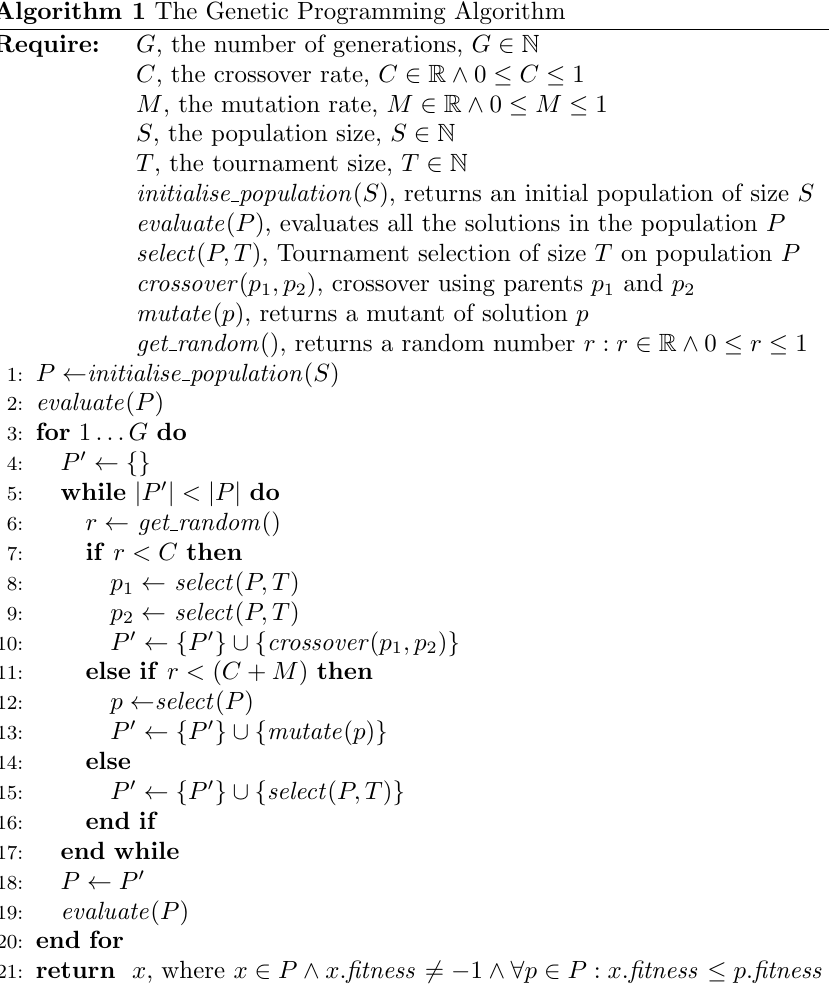
Algorithm 1 The Genetic Programming